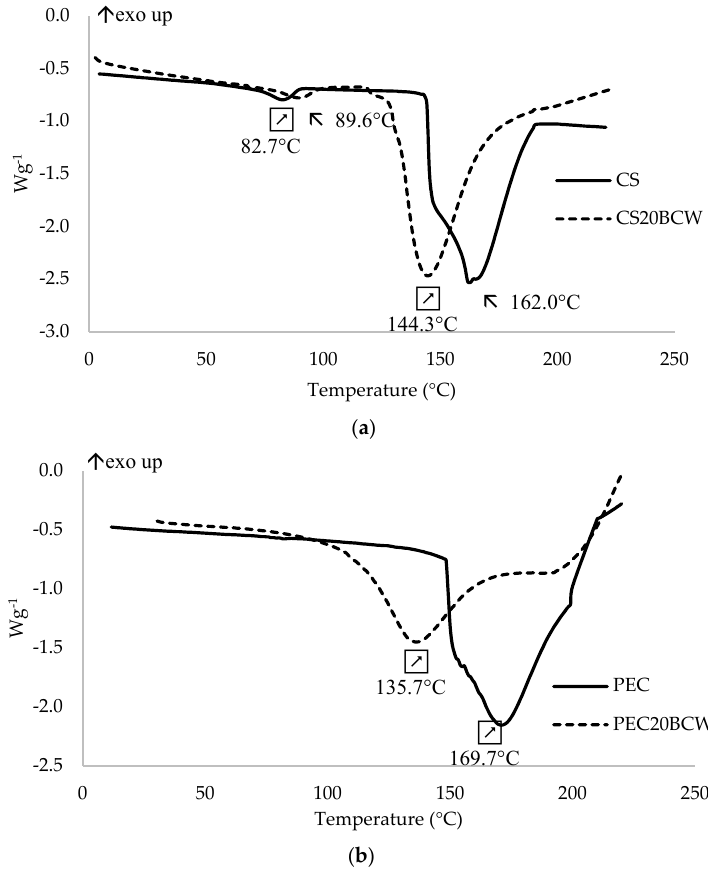
Figure 3. DSC thermograms (1st heating) of chitosan ( a ) and pectin ( b ) films without or with 20% ( w / w ) blackcurrant powder (BCW).